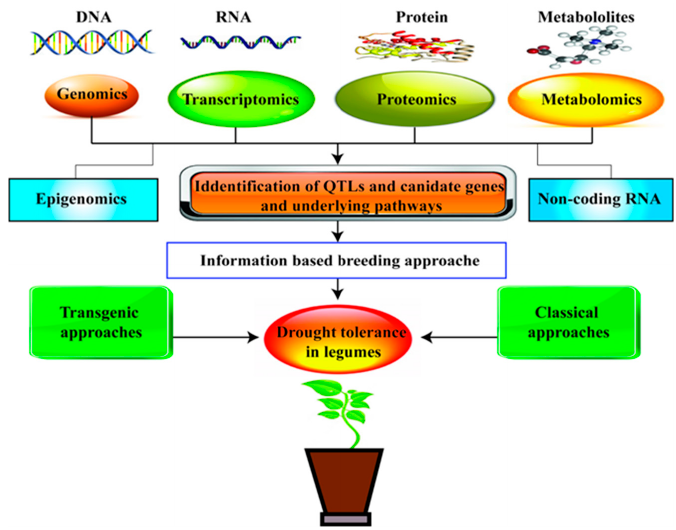
Figure 3. Schematic representation of the ‘omics’ approach for drought tolerance in